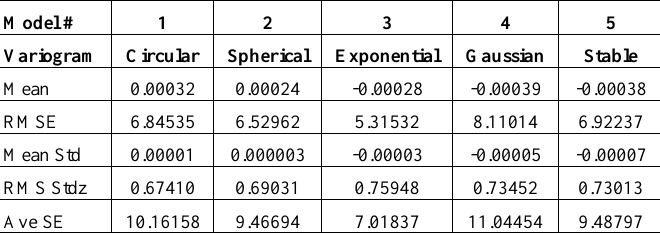
Table 1. Preliminary test results in selecting a variogram